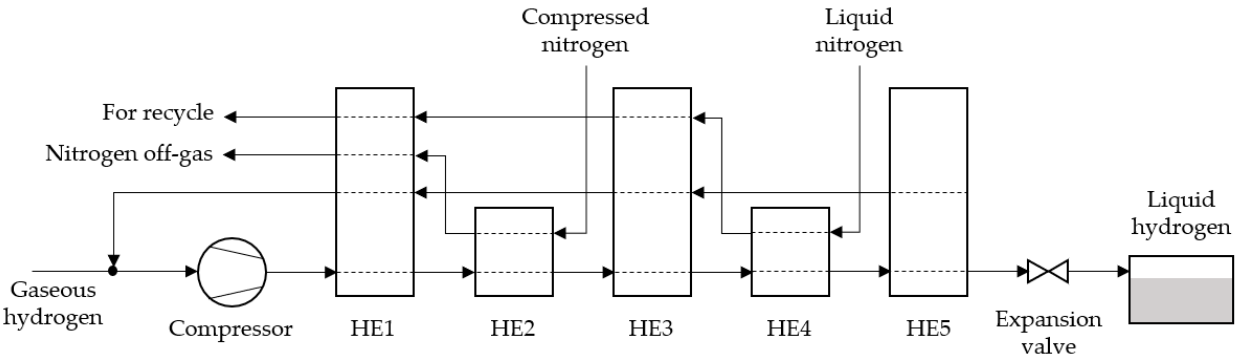
Figure 5. Basic schematic diagram of Linde–Sankey process for liquid hydrogen production.